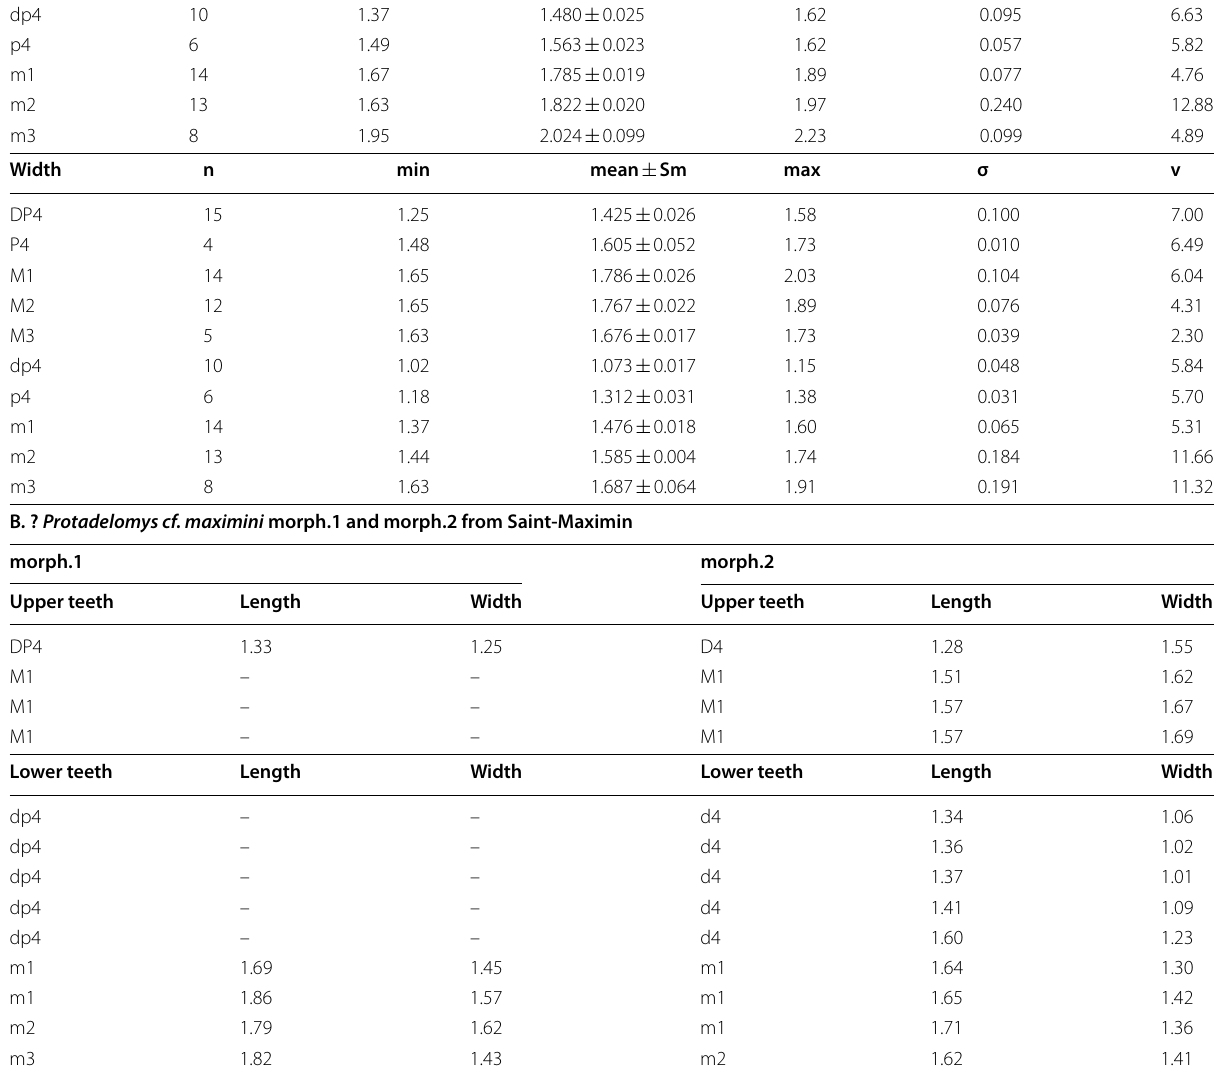
Table 7 Range of the size variations (length and width: min., max.; average loci of teeth of ? Protadelomys nievesae Peláez‑Campomanes, 1995, from Casa Ramon (MP 12?, Huesca, Spain) A. Protadelomys maximini. Saint‑Maximin